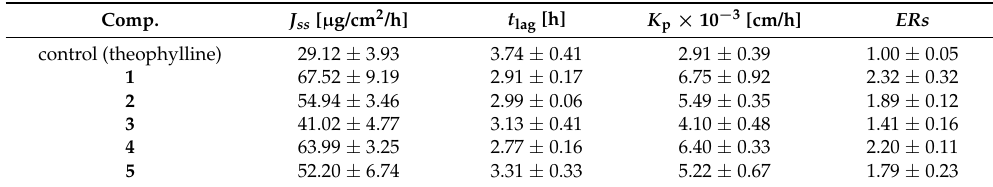
Table 4. Permeation parameters of theophylline in range 6–12 h without (control) and with tested CPEs 1 – 5 from propylene glycol:water (1:1): steady-state permeation fluxes ( J ), corresponding lag times ( t lag ), permeability coefficients ( K p ), and enhancement ratios ( ERs ). All values are expressed as mean ± SD ( n = 5